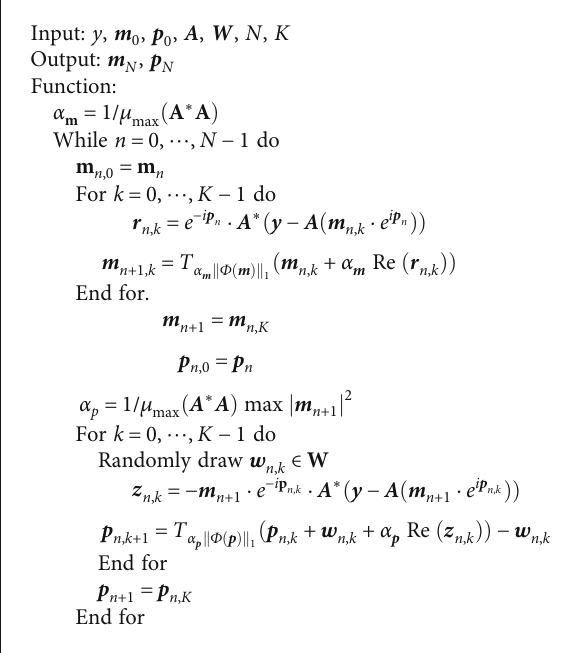
Algorithm 1: Pseudocode of the proposed